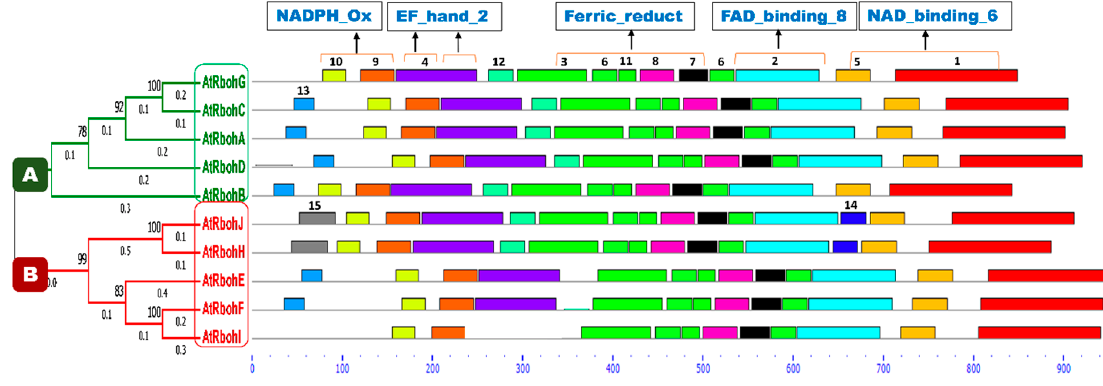
Figure 11. Conserved motif analyses of Rboh proteins. Phylogenetic tree is classified into group A and B, which are labeled with green and red color boxes, respectively. Motif numbers from 1 to 15 with corresponding colors (see also Figure S2) assigned by the MEME suite tool are indicated at top of each motif. Motifs’ heights depict the significance of match, whereas motifs’ widths display the number of amino acids in the respective motif. Characteristic domains corresponding to motifs are indicated at the top of the figure. Rboh proteins containing EF_hand_2 motifs are highlighted with orange lines on motif 4. The X -axis shows the number of amino acids.